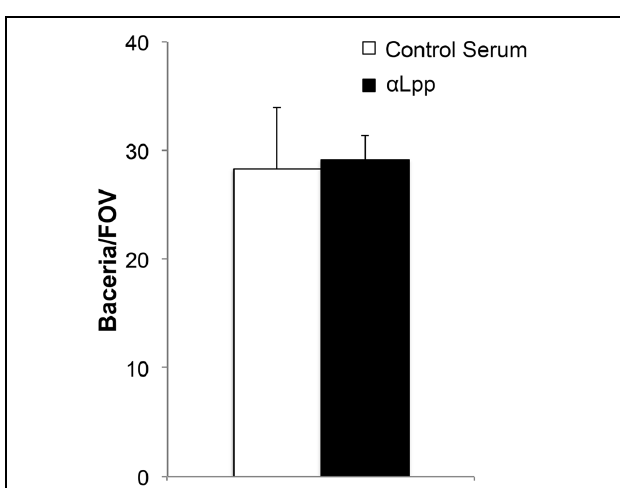
FIGURE 5 | Plg bound by Lpp can be converted to active plasmin by uPA. A Plg activation assay was performed using BSA (negative control), Lpp, and borrelial enolase (positive control) as coating proteins and human urokinase plasminogen activator (uPA) as the activator. ∗ p < 0.05 when compared to BSA negative control value.